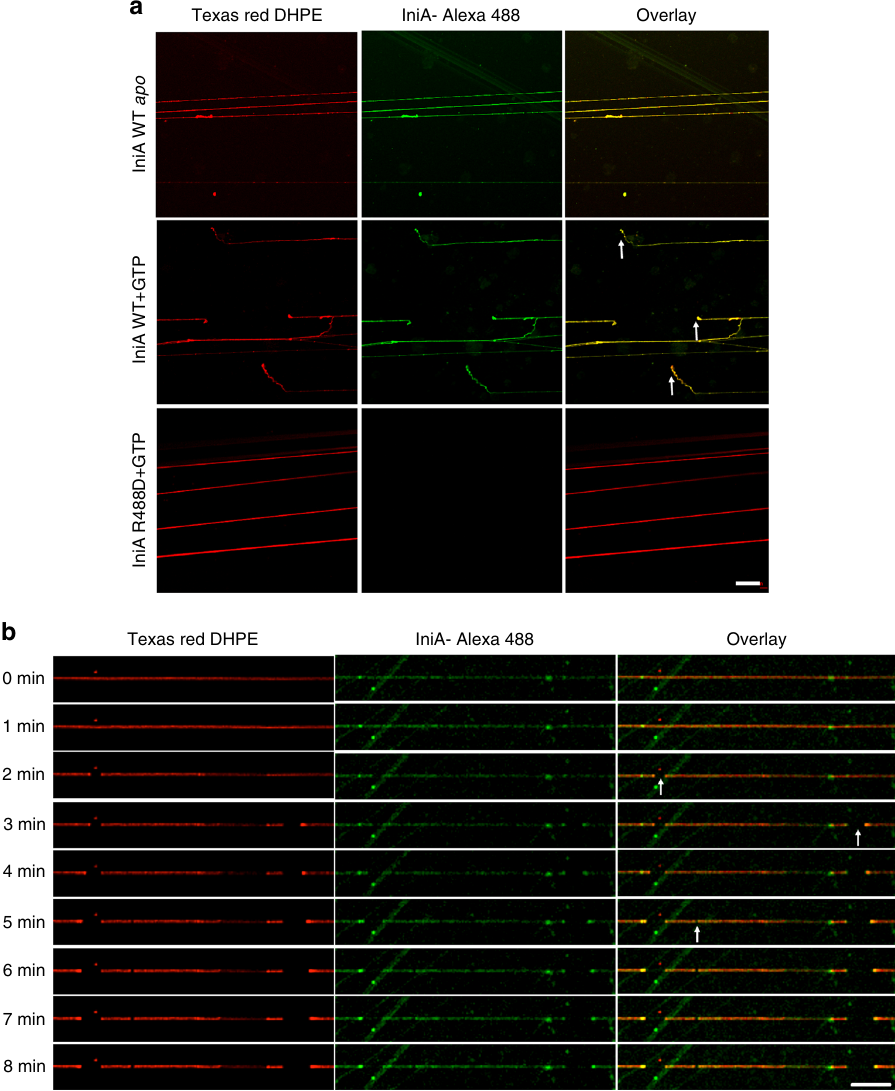
Fig. 6 Membrane fi ssion by IniA. a SMrTs (red) were treated with wild-type IniA (IniA WT) and R488D mutant in the absence or presence of 5 mM GTP. Protein localization and tube cleavage were monitored using confocal microscopy. The arrows indicate the cleavage sites. Scale bar, 20 µ m. b As shown in ( a ), but with wild-type IniA recorded along with the time course after GTP addition. The arrows indicate the cleavage sites. Scale bar, 20 µ